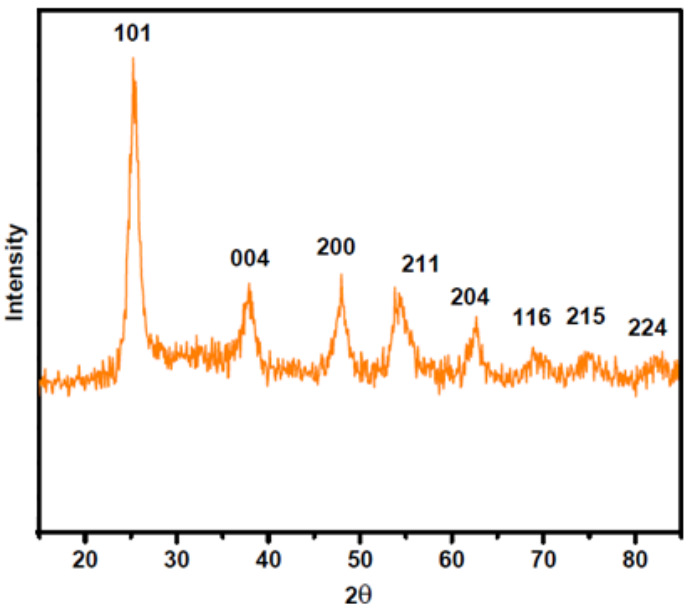
Figure 1. X-Ray diffraction pattern of TiO 2 nanoparticles.